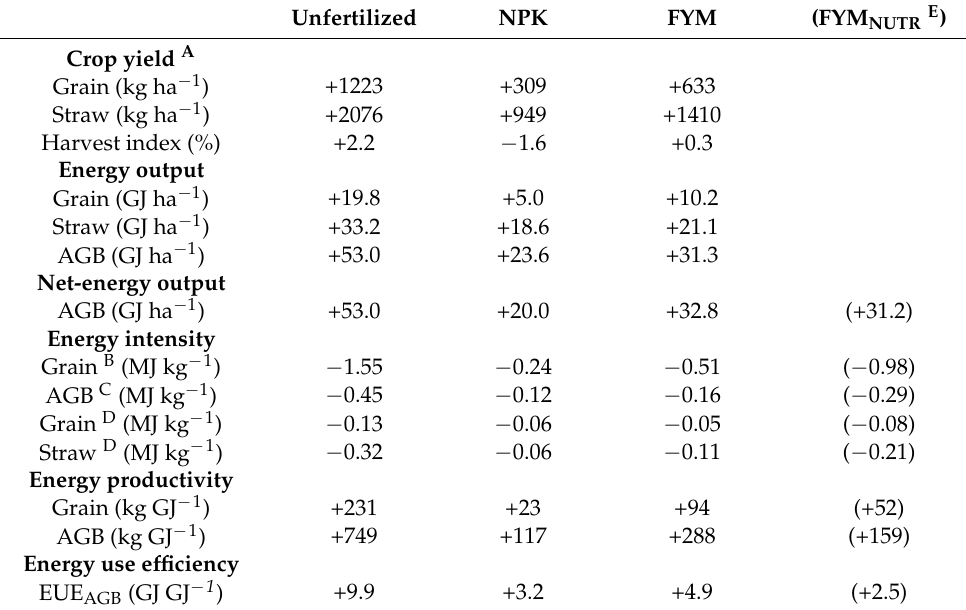
Table 8. Differences between RR and CR (mean over years